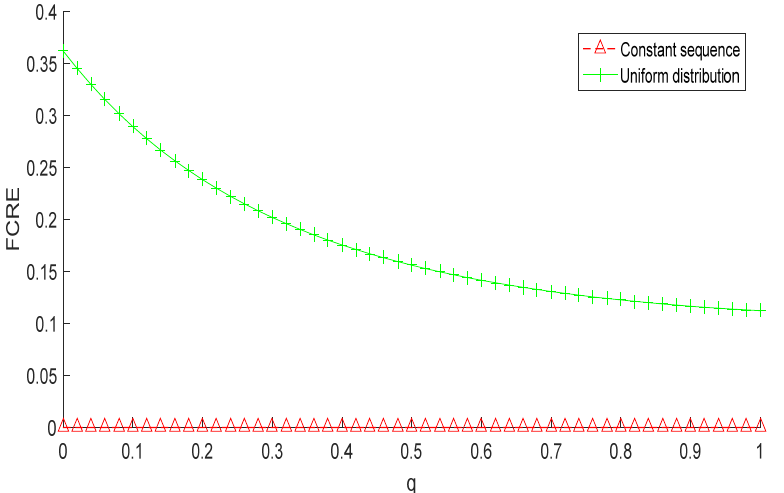
Figure 2. The fractional cumulative residual entropy of constant sequence and uniform distribution on [0, 1] .